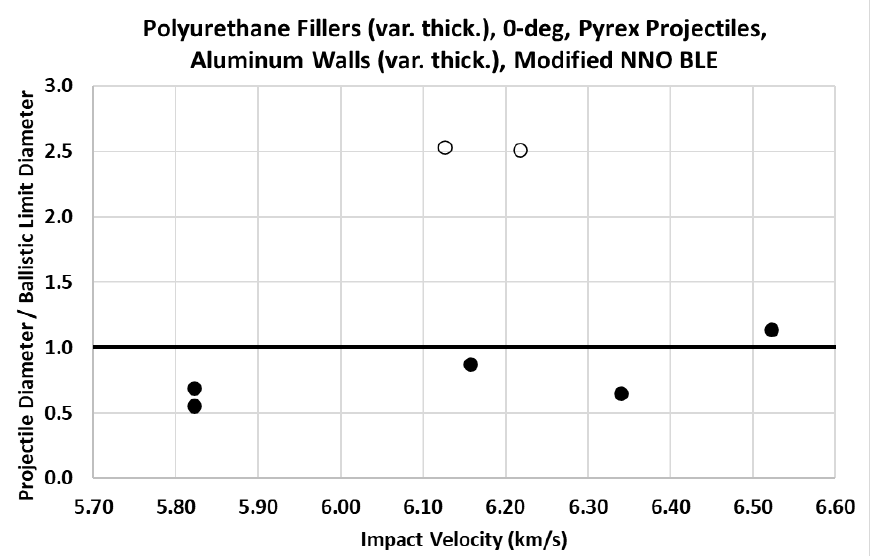
Figure 7. Comparison of Original and Modified NNO BLEs against P/NP data in [4,6] for Dual-Wall Systems with Aluminum Walls and a Polyurethane Filler.